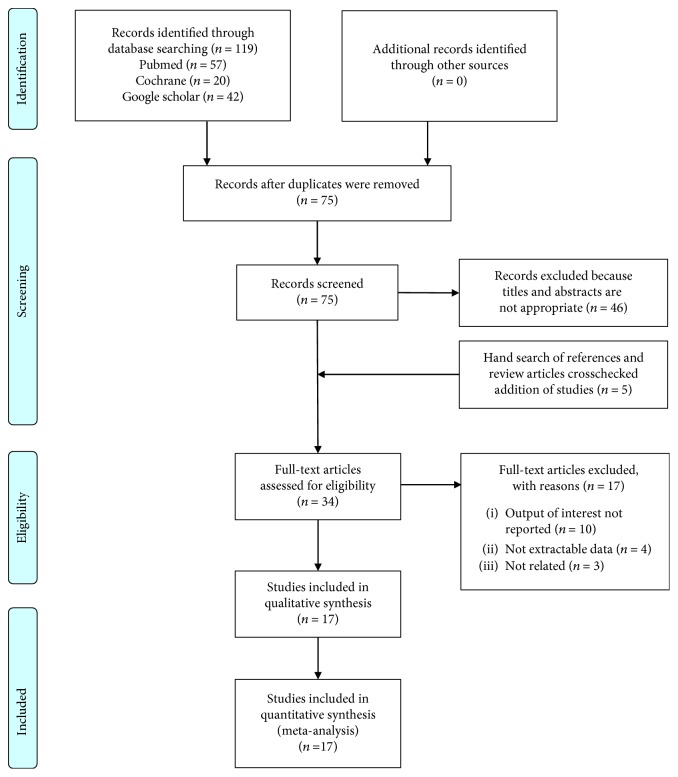
Flowchart of literature search and study selection.